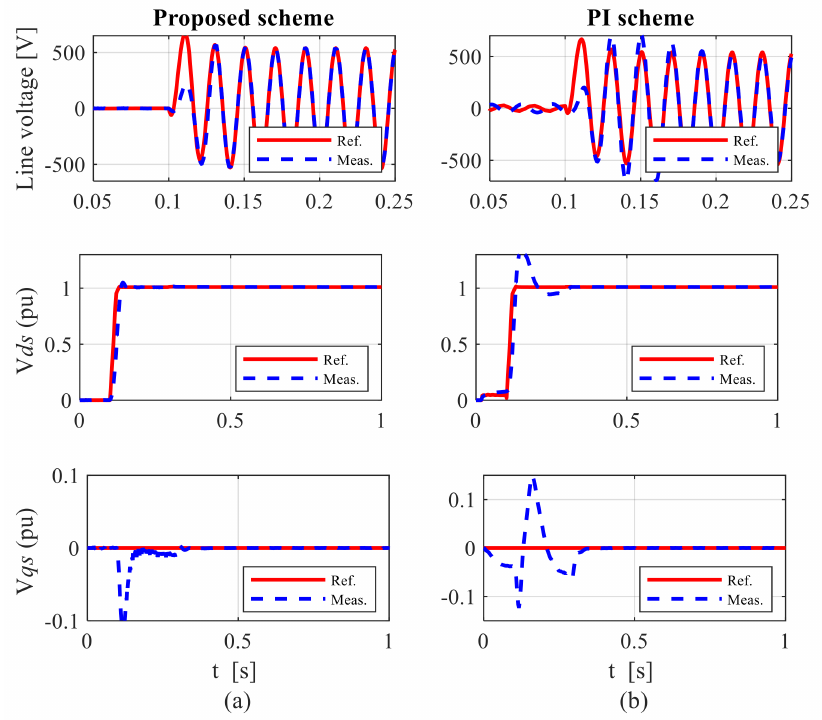
Figure 5. Control performances during sub-synchronous speed operation under balanced grid conditions for L m(perturbed) = 200% L m : ( a ) proposed scheme and ( b ) PI scheme.